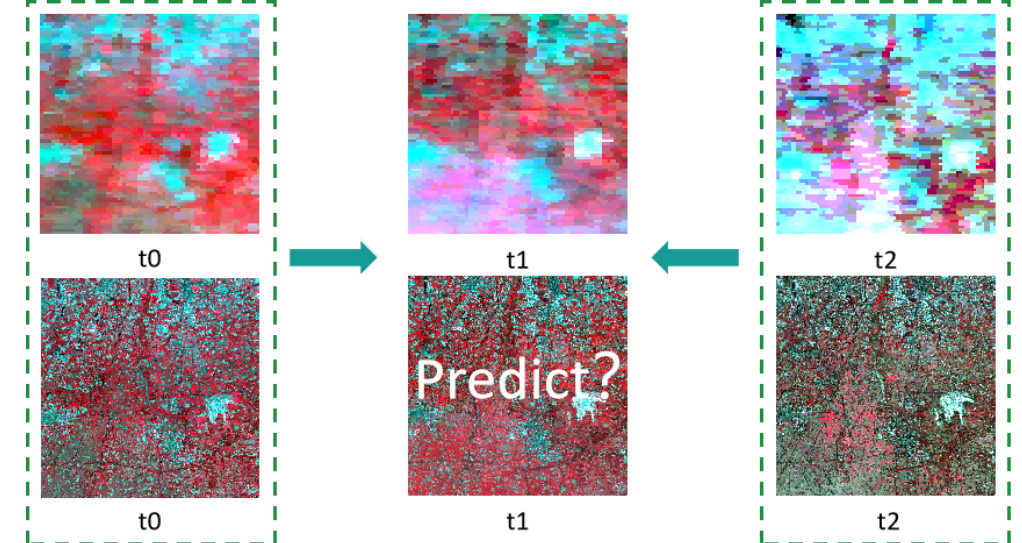
Figure 2. Predicted image based on spatiotemporal fusion, in which all images of t0 and t2 and the MODIS at time t1 are known images, and the Landsat image of t1 is the prediction image.